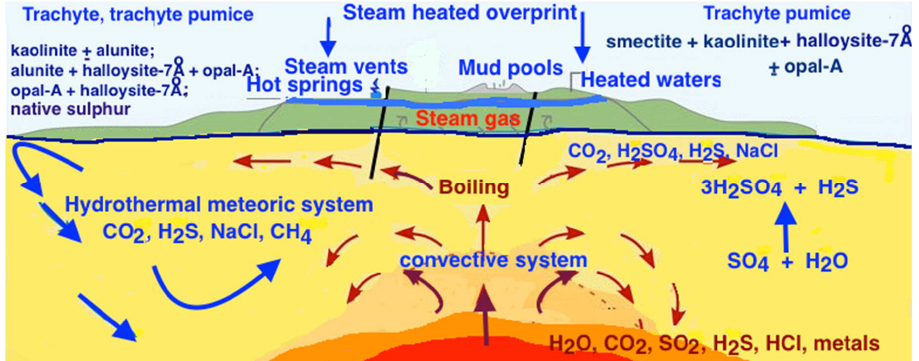
Figure 9. The acid-sulfate alteration adapted model [86] of the active hydrothermal system of Furnas volcano, The Azores Archipelago fluids (pH < 4 at 20 ◦ C) circulation in a convective meteoric system, the Al becomes more soluble than silicon. Low or high supersaturated solution of Si and Al will favor the crystallization of kaolinite or halloysite-7 Å